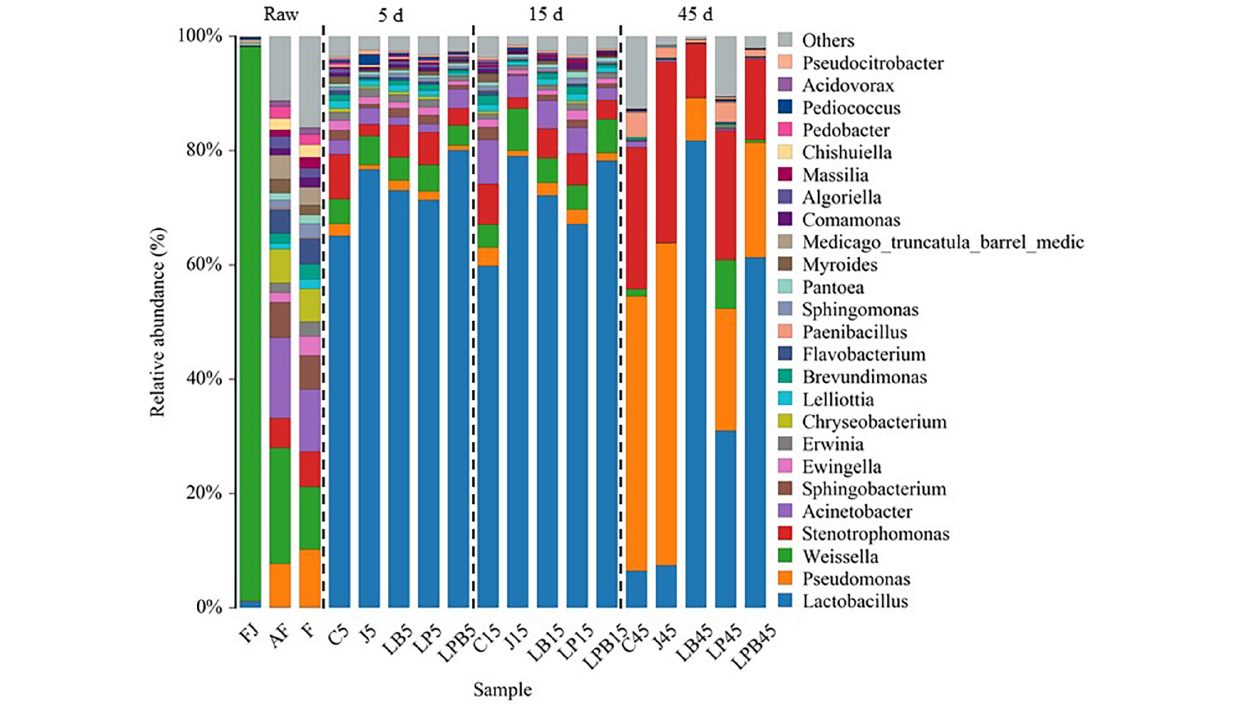
FIGURE 3 | Bacterial community (genus level) of mixed silage. AF, fresh lucerne; FJ, pre-fermented juice; F, mixture; C, control; J, pre-fermented juice-treated silage; LP, L. plantarum -treated silage; LB, L. buchneri -treated silage; LPB, L. plantarum + L. buchneri- treated silage.